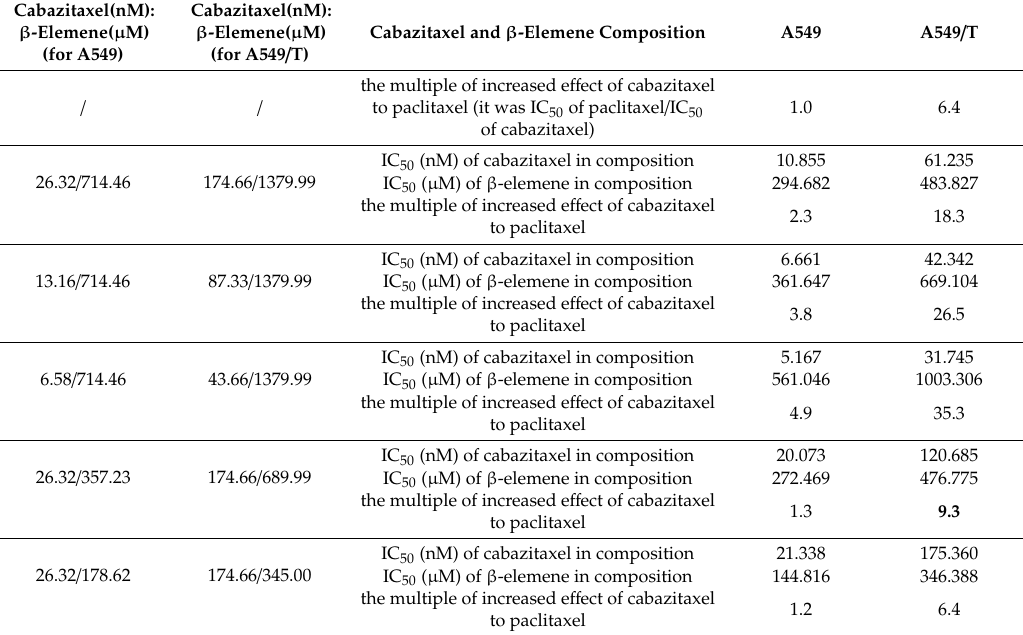
Table 2. Combined e ff ect of overcoming resistance of cabazitaxel and β -elemene compositions. Cabazitaxel(nM): β -Elemene( µ